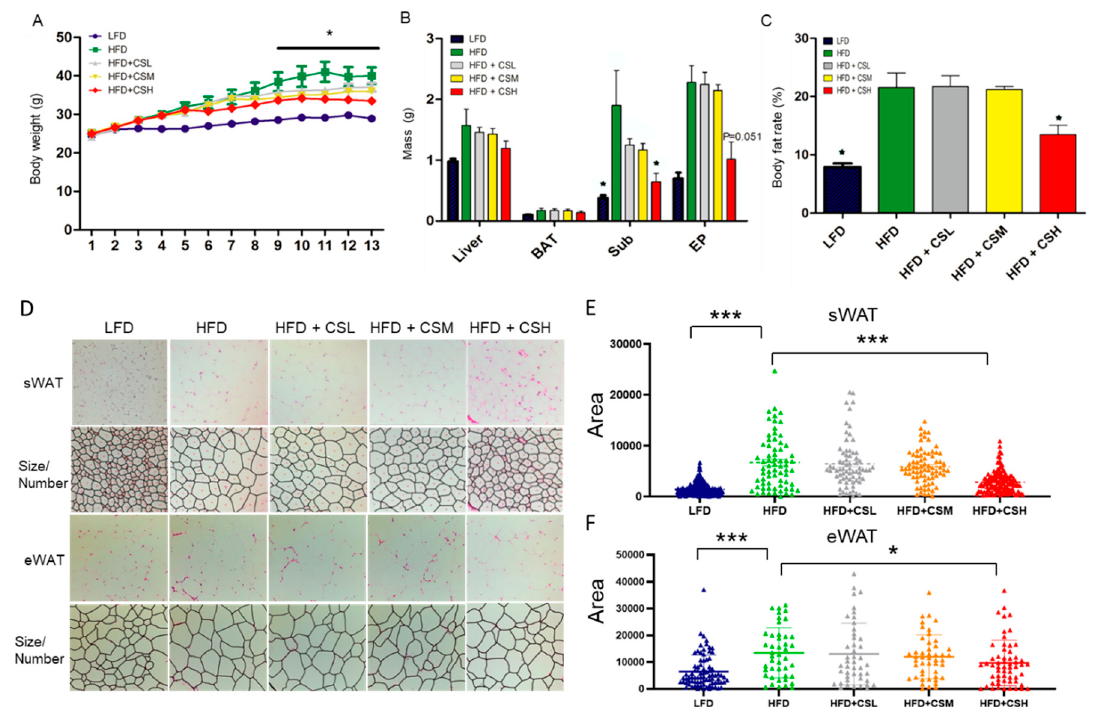
Figure 1. WECS treatment inhibits obesity in the DIO mice. The effect of different concentrations of WECS on body weight ( A ), organ weight ( B ), body fat rate ( C ), and the morphological characteristics of sWAT and eWAT ( D ). The cell area frequency of sWAT and eWAT in D are shown for the five different groups (Figure 1 E , F ). Bars represent the mean ± SEM, n = 7–9. * p < 0.05, *** p < 0.001, HFD+CSH compared with HFD control after 9 weeks ( A ).